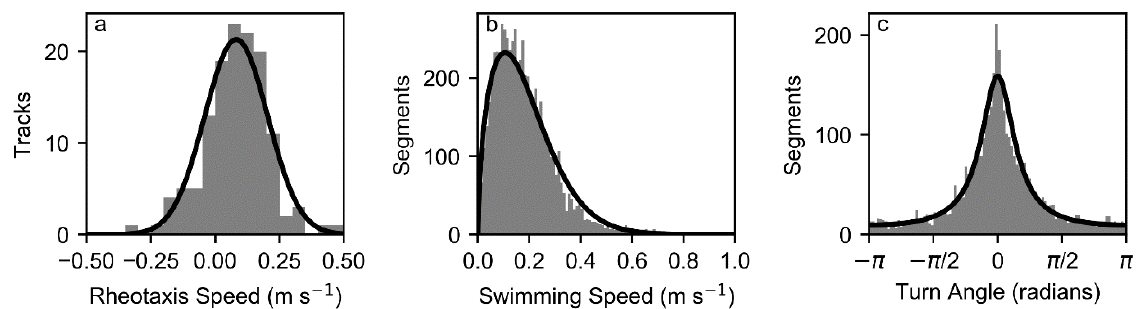
Figure 4. Histograms and corresponding best fit statistical distributions of swimming behavior components fit to swimming speeds estimated from position dataset: ( a ) rheotaxis speed, with positive indicating upstream swimming; ( b ) swimming speed of CRW; ( c ) turn angle of CRW.